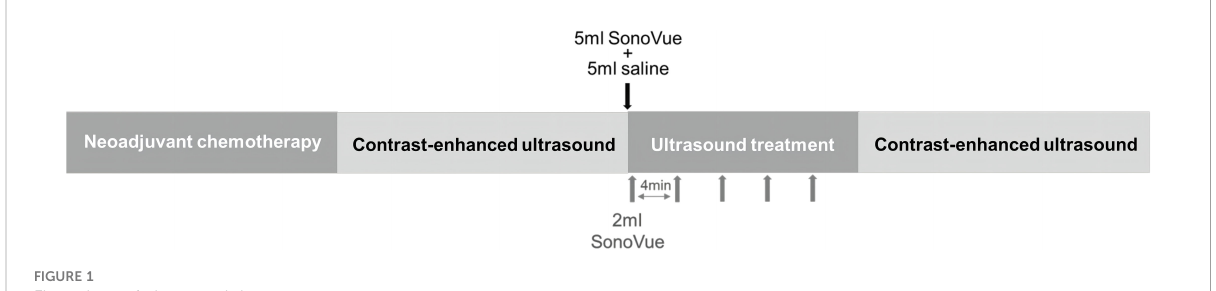
FIGURE 1 Flow chart of ultrasound